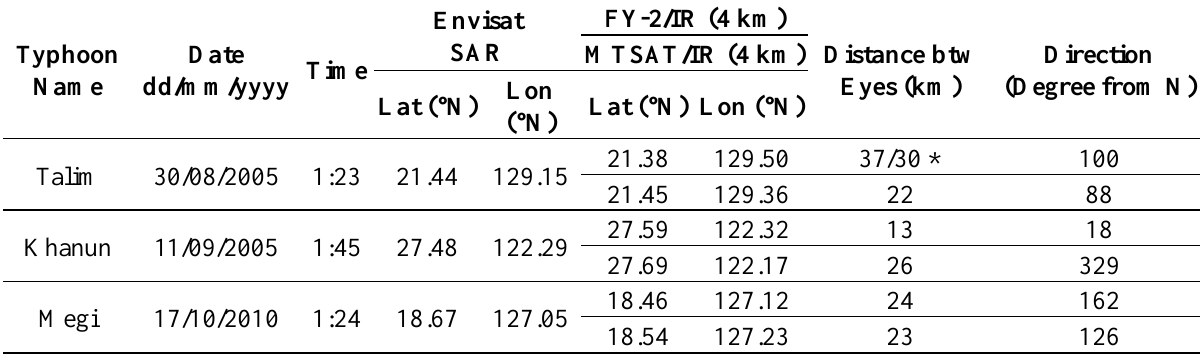
Table 1. Summary of all case studies of typhoon ―eye‖ and center distance using Envisat SAR data, FY-2 and MTSAT IR